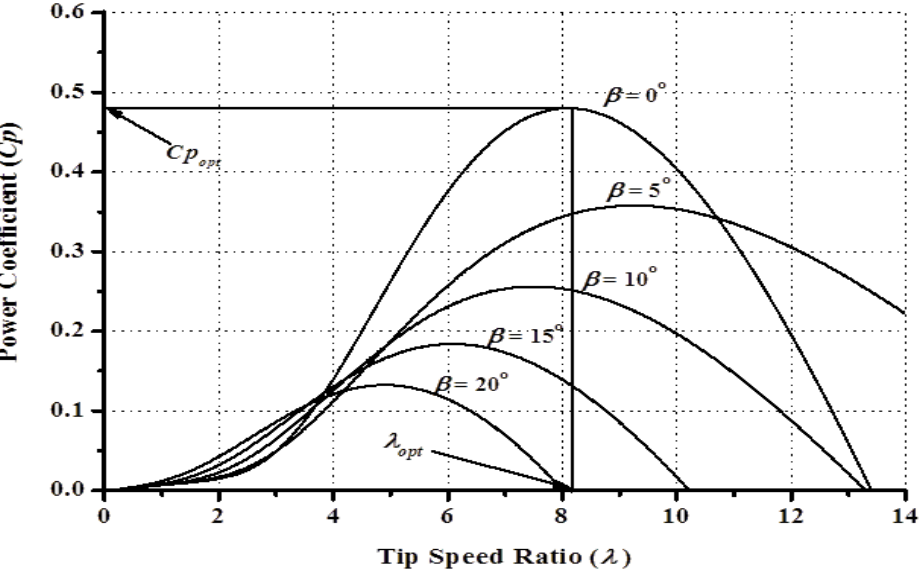
Figure 2. Turbine power characteristic ( β =